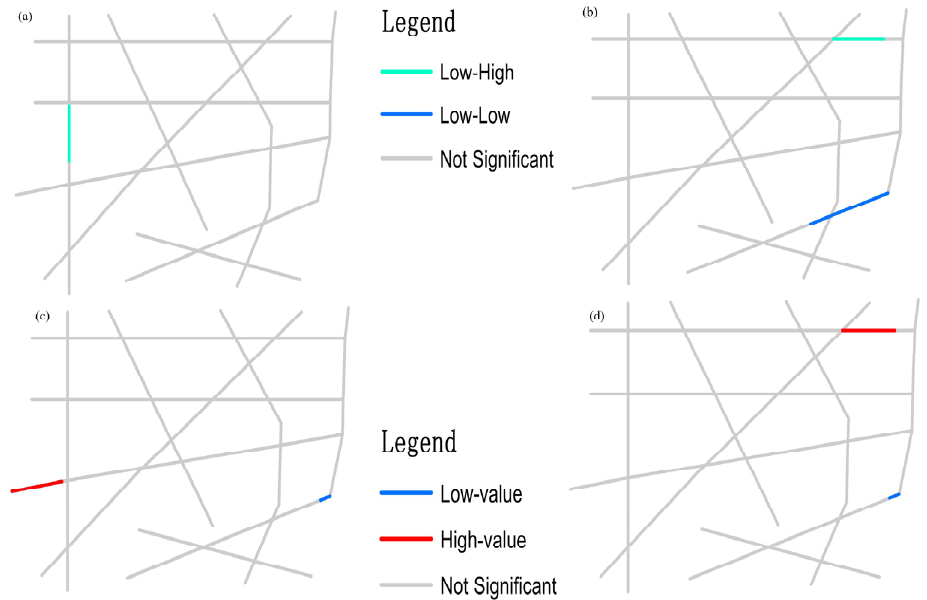
Figure 5. Distributions of spatial clusters, using: ( a ) ILINCS adjusted for the base distribution; ( b ) ILINCS using posterior risk and not adjusted for the base distribution; ( c ) GLINCS adjusted for the base distribution; ( d ) GLINCS using posterior risk and not adjusted for the base distribution.